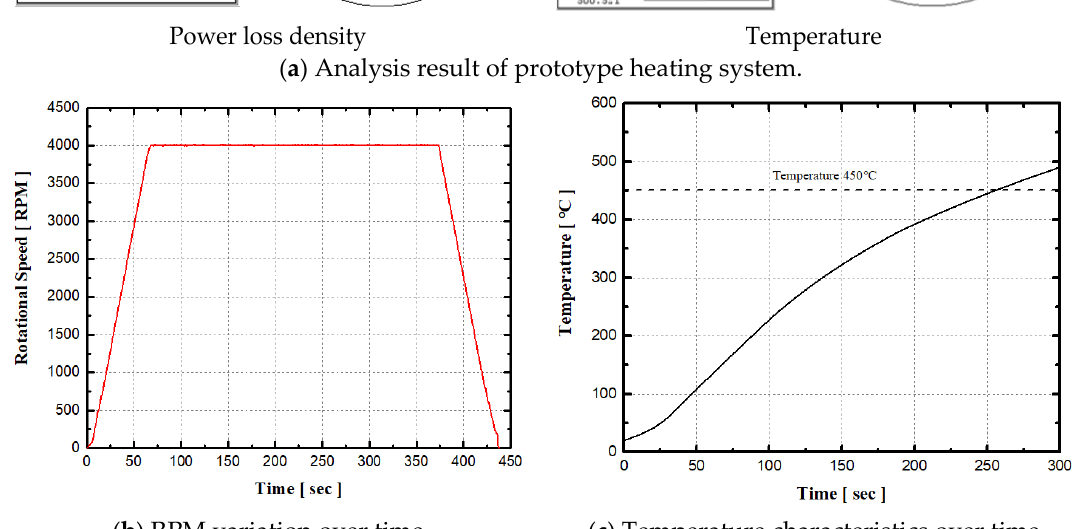
Figure 4. Analysis result of base model: ( a ) Analysis result of prototype heating system ( b ) RPM – time graph; and ( c ) temperature – time graph.